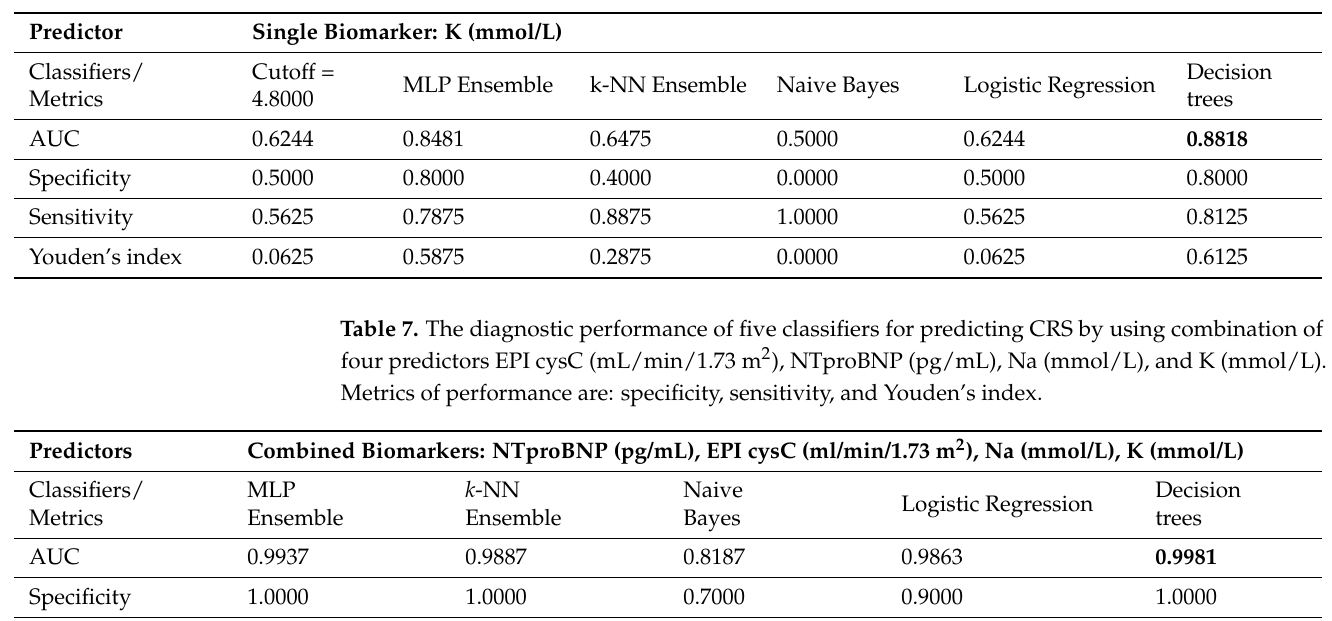
Table 6. The diagnostic performance of six classifiers for predicting CRS by using single predic- tive variable: potassium concentration K (mmol/L). Metrics of performance are: AUC, specificity, sensitivity, and Youden’s index.